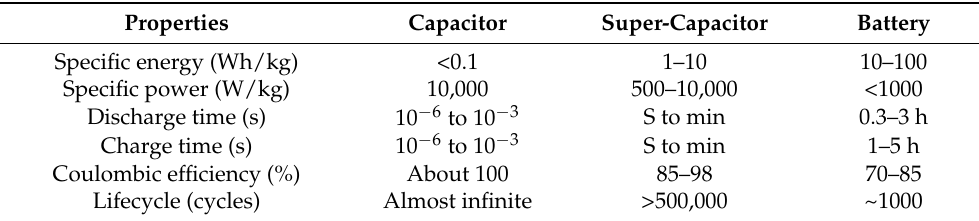
Figure 1. A Ragone plot for different electrochemical energy storage devices of the density versus energy density scale. Reproduced with permission from [17]. Catalysts, 2020. Table 1. Comparative analysis of selected technologies for the storage of electrical energy. Repro- duced with permission from [28] 2006,